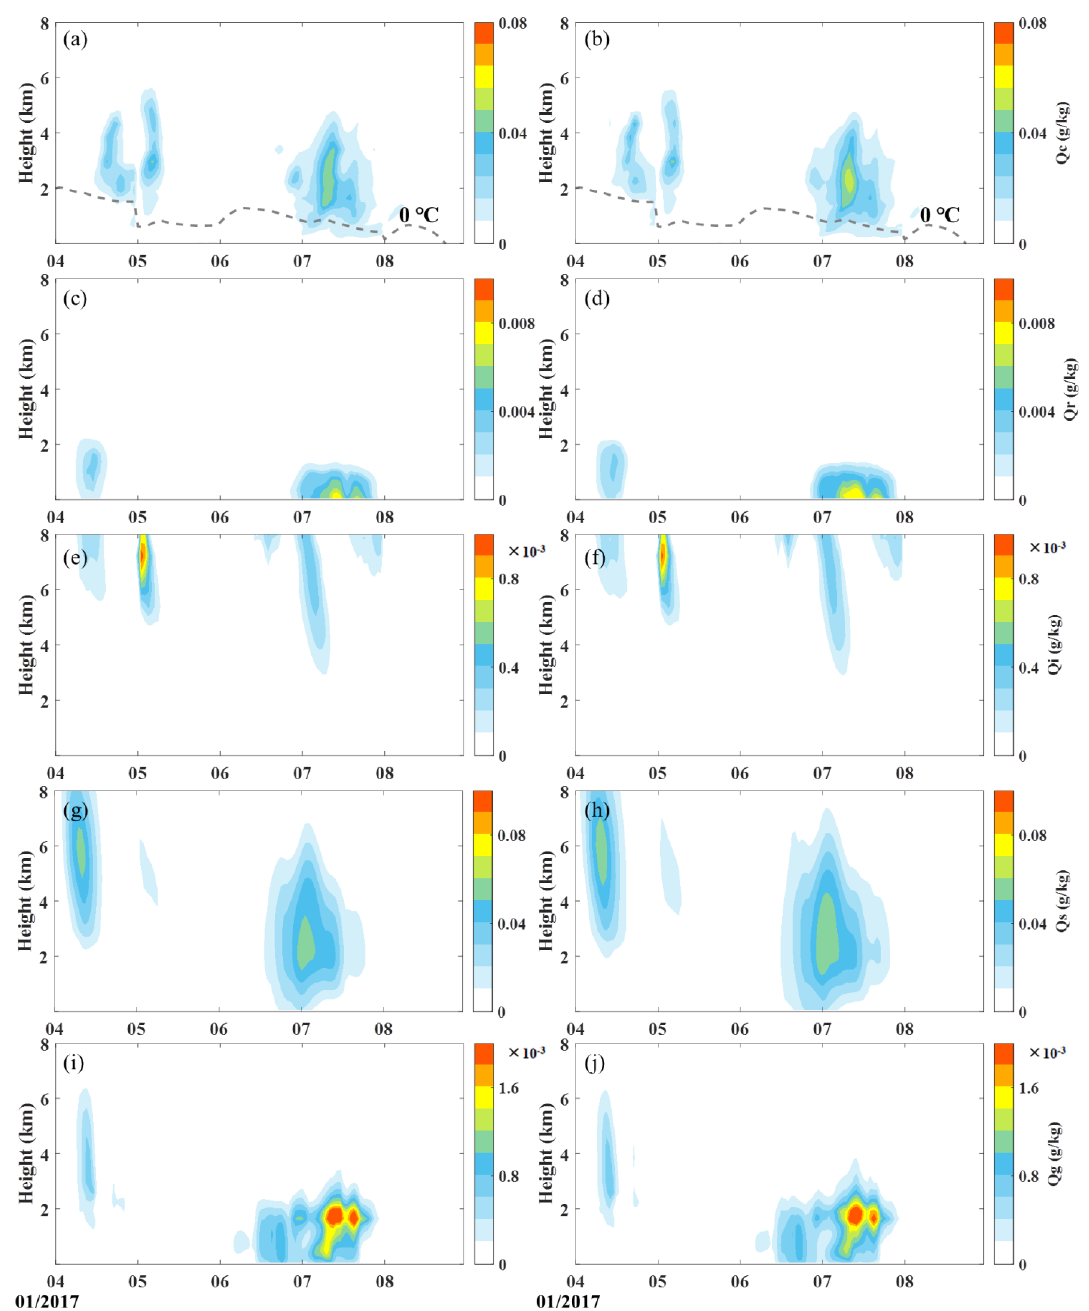
Figure 4. The vertical distribution of regional mean hydrometeor mixing ratios (Qc, Qr, Qi, Qs, and Qg) in Jing–Jin–Ji from the (left column) E1 and (right column) E2